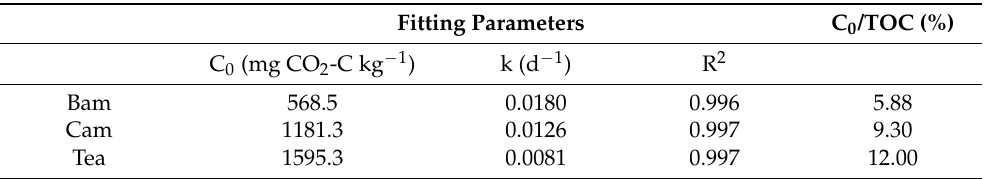
Figure 1. Cumulative amount of soil organic matter mineralization over incubation days ( a ) and within 121 days of incubation ( b ) in bamboo (Bam), camphor (Cam), and tea (Tea) plantations. The different letters adjacent to the bars were statistically different at p < 0.05. Table 2. Mineralization parameters of soil organic matter in bamboo (Bam), camphor (Cam), and tea (Tea) plantations.